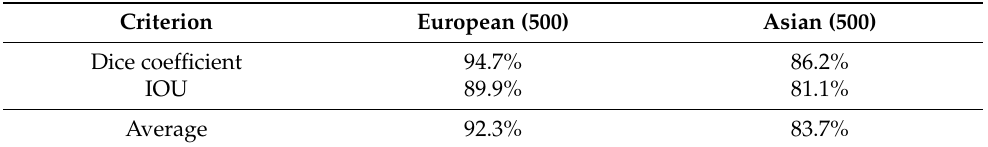
Table 5. Accuracy of racial hair segmentation.